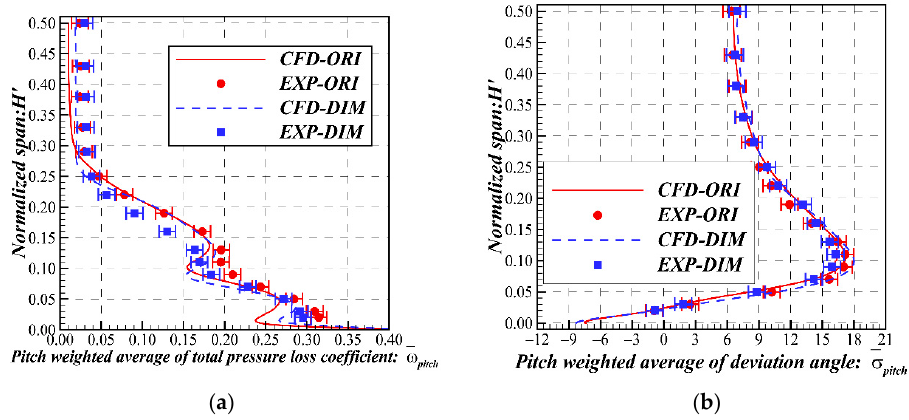
Figure 8. Pitch weighted average of performance parameters along the spanwise direction (DIM represents the case of λ = 0.375). ( a ) Total pressure loss coefficient; ( b ) deviation angle.